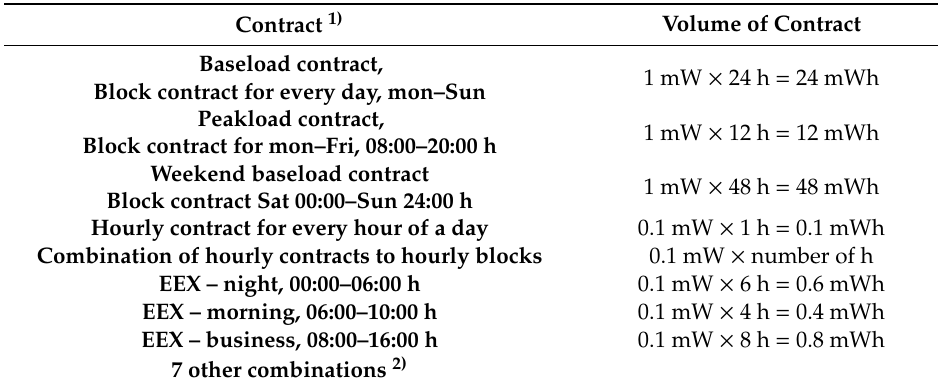
Table A1. EEX power